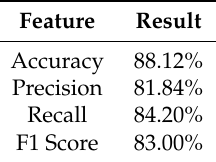
Table 6. Performance results of the proposed Caoshu recognition model.